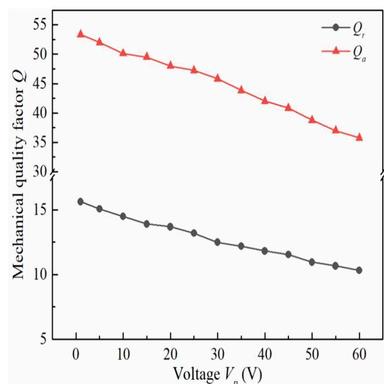
The mechanical quality factors of the PMN-PT composite as a function of the AC driving voltage.